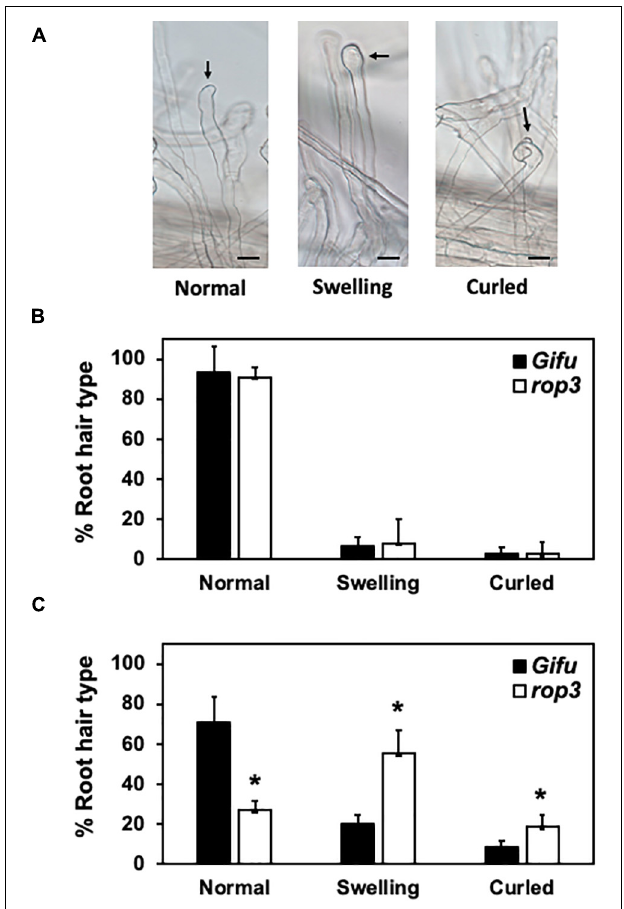
FIGURE 3 | rop3 plants showed a misregulation of RH deformation after interaction with M. loti . RHs deformation types were counted in rop3 and Gifu wild-type plants. Representative pictures of RH types evaluated in Gifu wild-type and rop3 plants, arrows point the site of interest, black bar = 40 µ m (A). RH deformation types without bacteria inoculation (B) and at 7 DAI with M. loti (C) . Bars represent mean values ( ± SD) of 3 independent experiments ( n > 15). The asterisk indicates statistical significance between rop3 and Gifu wild-type according to one way ANOVA test and a post hoc analysis ( p <